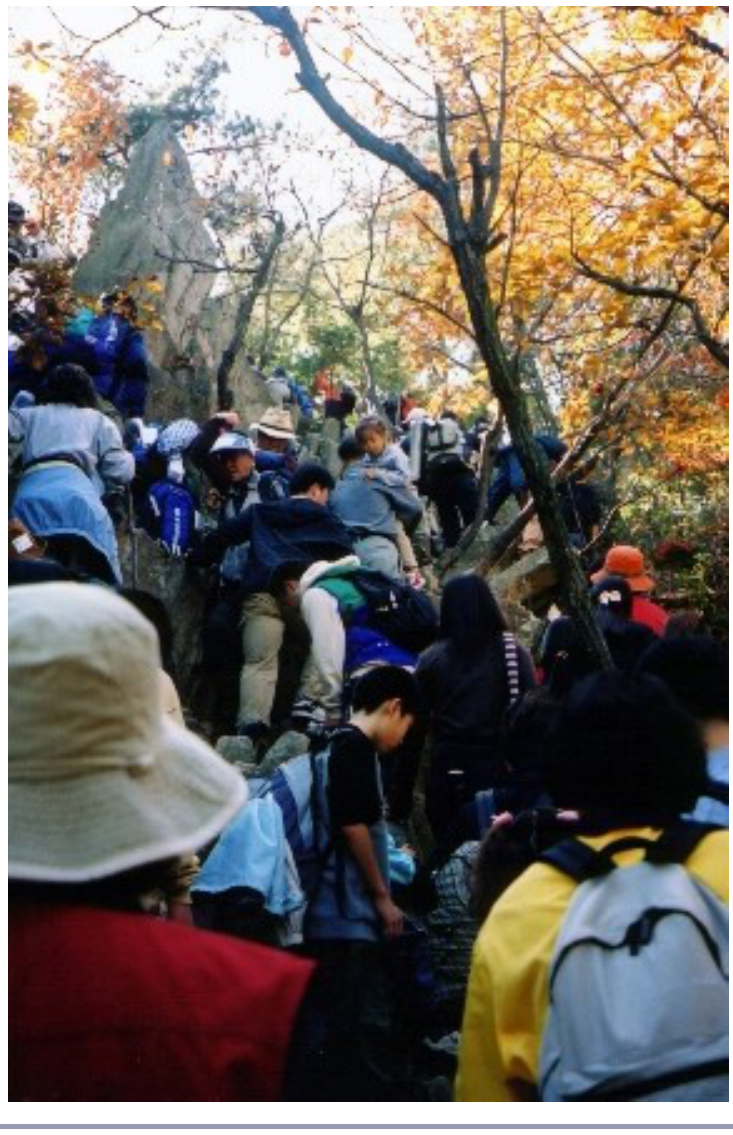
Fig. 2. Heavy recreational use of hiking paths in Seoul's greenbelt. (Photo: Chris